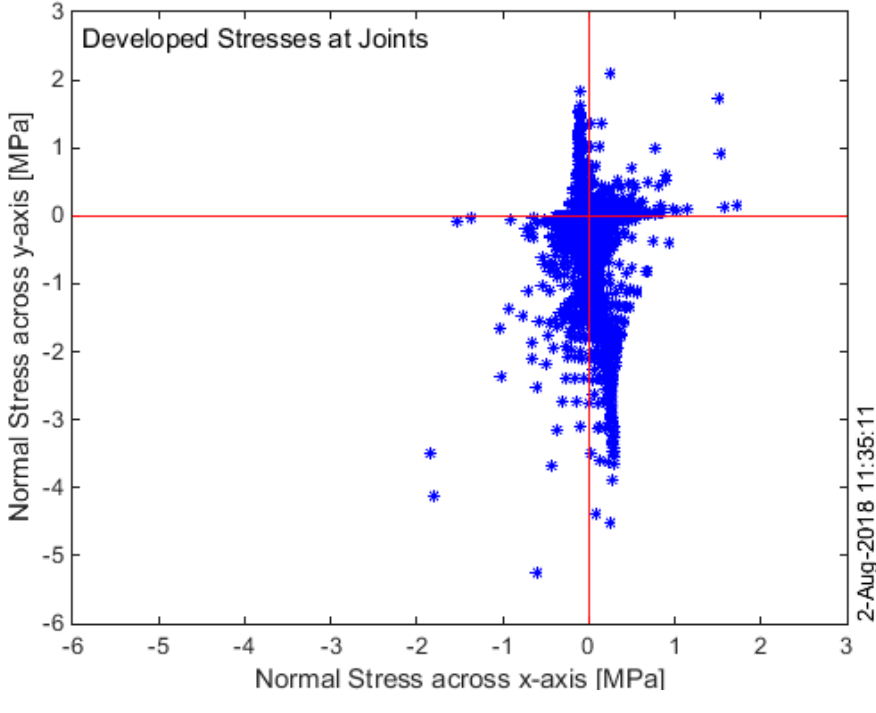
Figure 26. Developed stresses in normal stresses terms (PGA = 0.40 g).